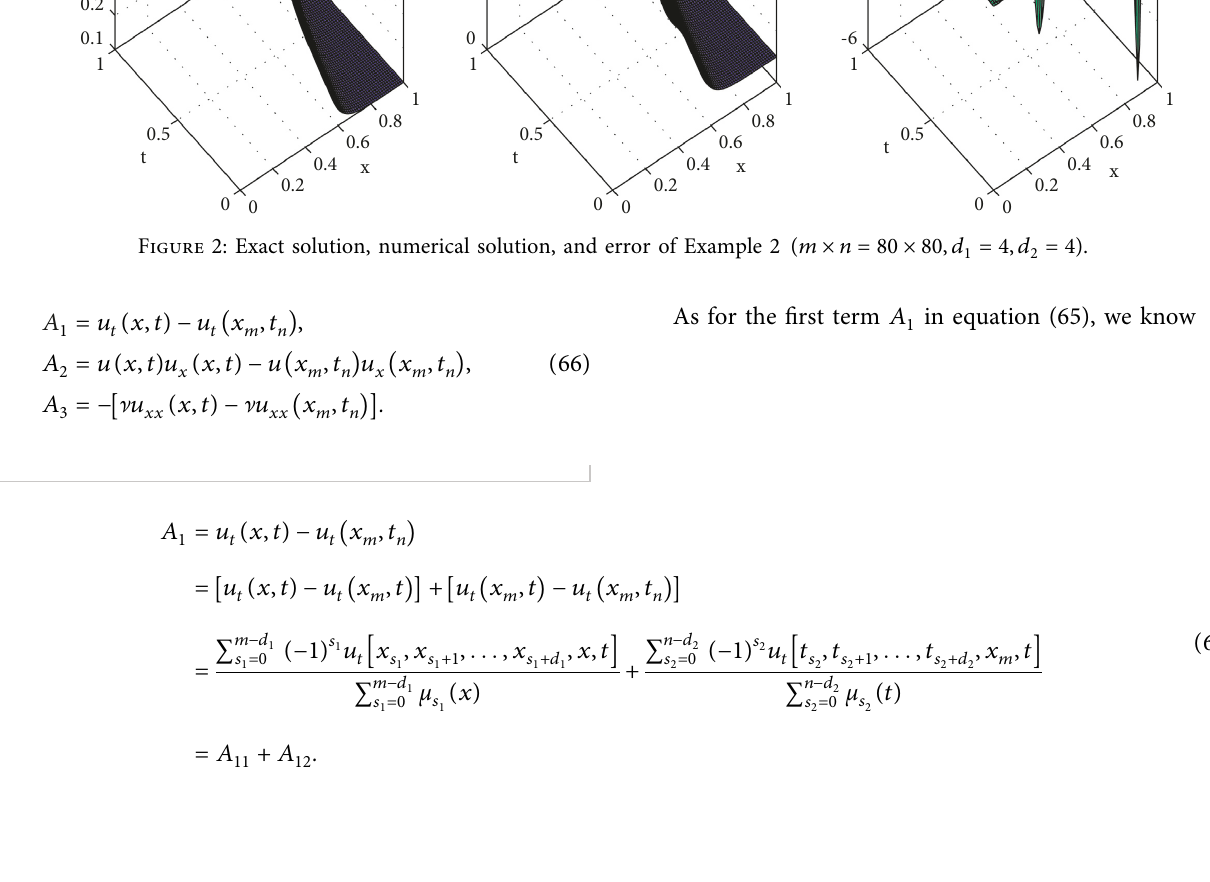
Figure 2: Exact solution, numerical solution, and error of Example 2 ( m × n � 80 × 80 , d